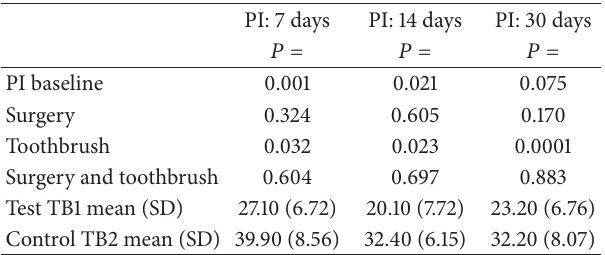
Table 1: Influence of the type of surgery (fixed factor) and of the toothbrush (random factor) on Plaque Index (PI) at 7, 14, and 30 days. PI mean values and Standard Deviation (SD) at three times are reported for both test (TB1) and control toothbrushes (TB2). Generalized Linear Model applied considering PI at baseline as covariate. PI: 7